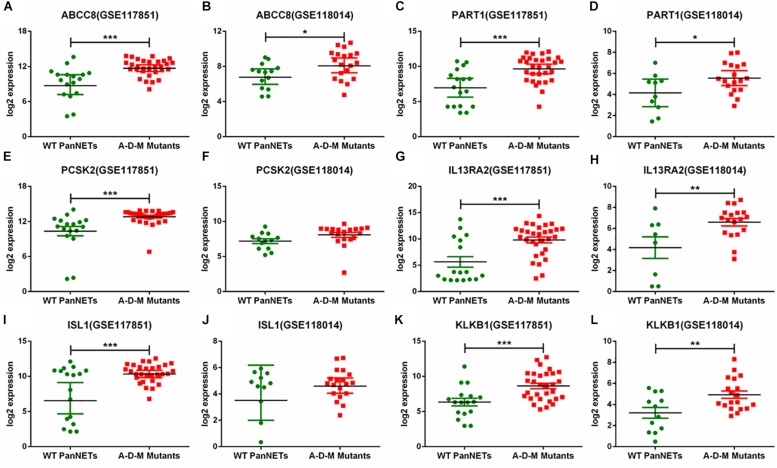
Six gene expression levels in A–D–M mutant and A–D–M wild-type PanNETs. (A,C,E,G,I,K) are the expression levels of six genes in GSE117851. (B,D,F,H,J,L) are the expression levels of six genes in GSE118014. ∗P < 0.05, ∗∗P < 0.01, ∗∗∗P < 0.001.